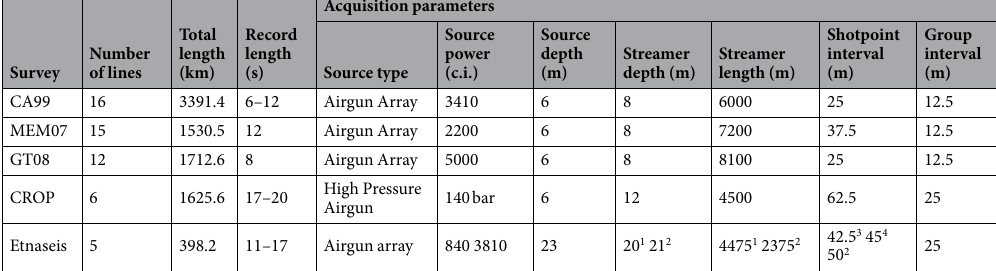
Table 1. Characteristics of the seismic reflection dataset. Notes The acquisition source power is conventionally expressed in cubic inches (c.i.) except for the CROP survey (bar). Etnaseis seismic line numbers as in Nicolich, et al . 42 : 1 E1, E2, E6; 2 E3, E5; 3 E6; 4 E1,